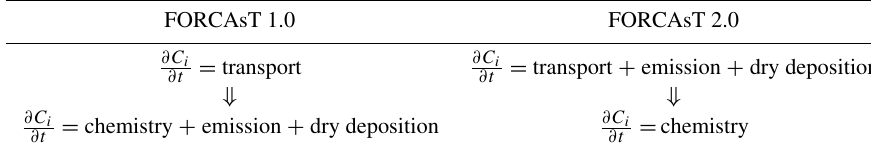
denotes the time evolution of concentrations of chemical species i . ∂t